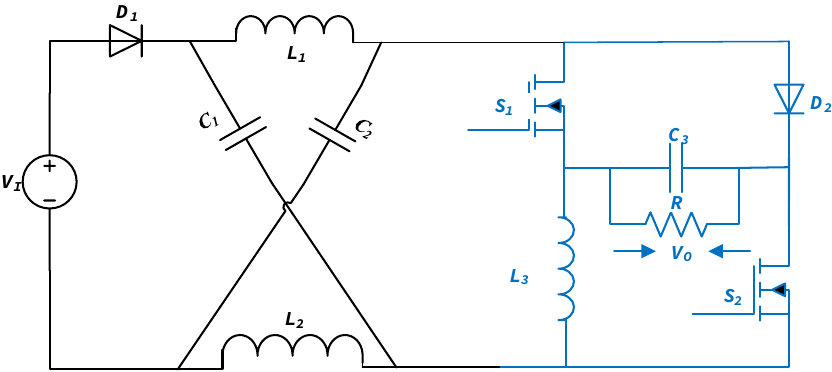
Figure 2. Configuration of the proposed high step-up, switched Z-source DC-DC boost converter (HS-SZC).